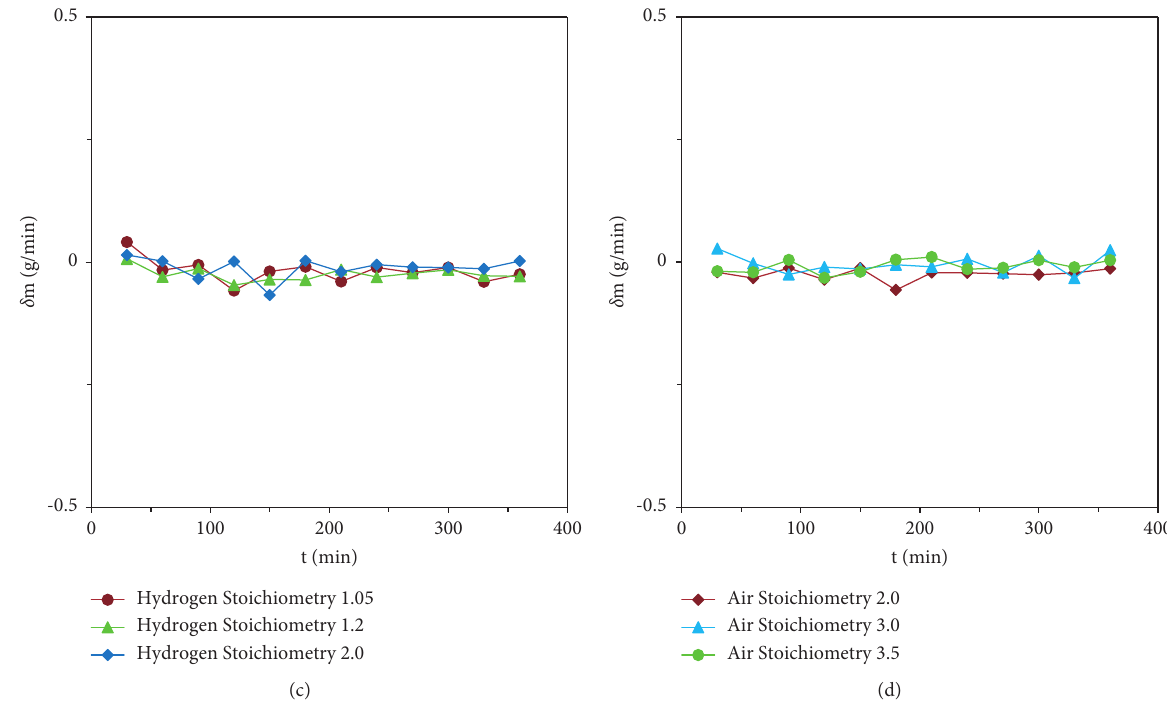
Figure 5: Change rate of water content in the fuel cell under different operation conditions. (a) Inlet gas temperature. (b) Inlet gas humidity. (c) Hydrogen stoichiometry. (d) Air stoichiometry.